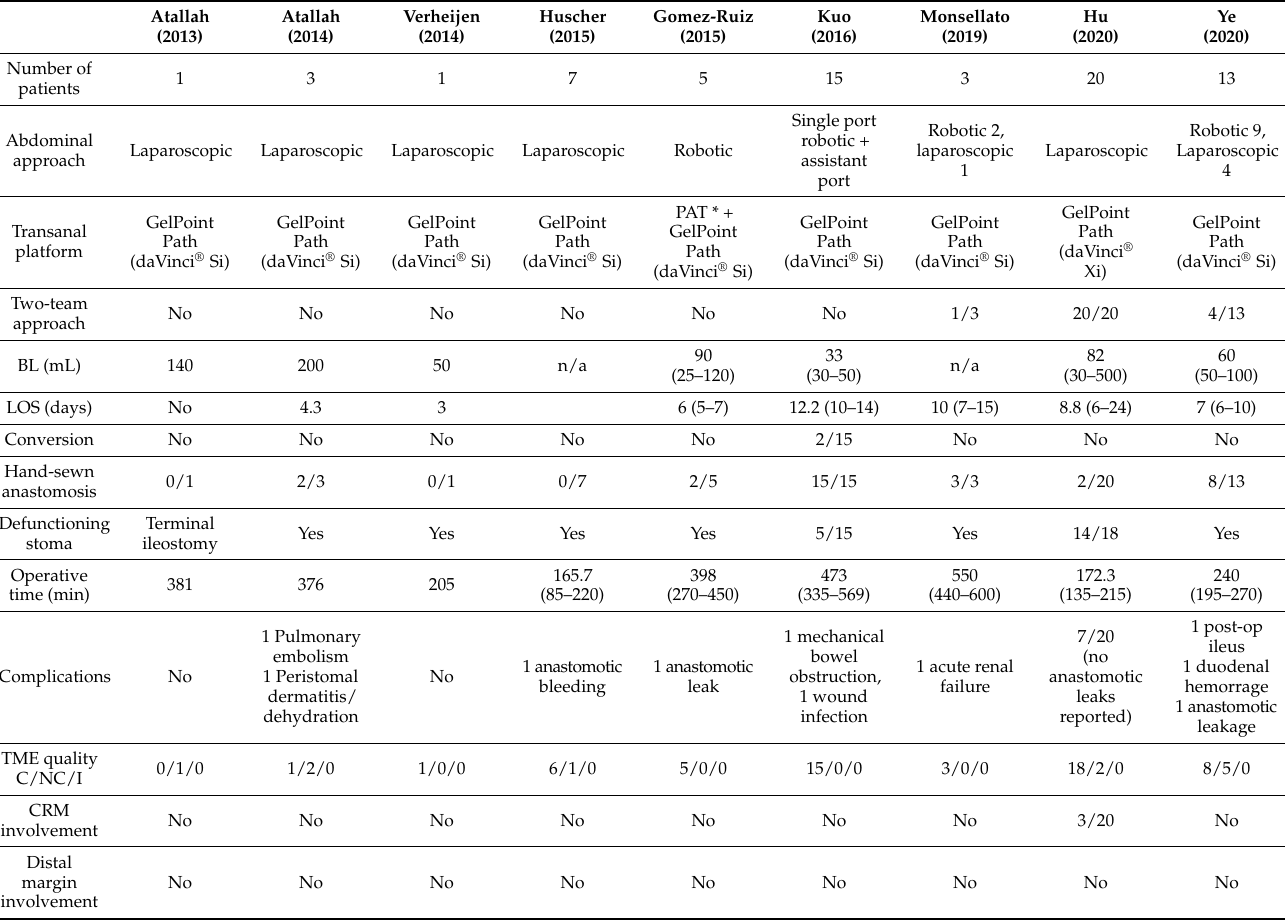
Table 1. Summary of published experience of RTaTME performed with da Vinci ® Robotic